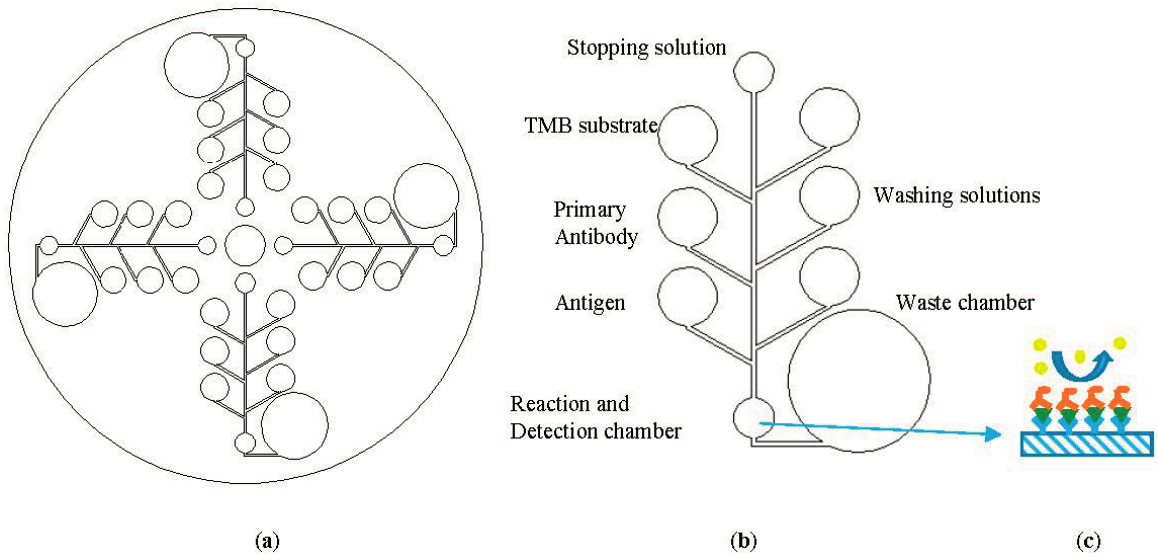
Figure 1. A general scheme of ( a ) a Lab-on-Compact Disc (LOCD) ELISA with four sets of assays; ( b ) a single assay showing reservoirs for various reagents; and ( c ) antigen coating on the detection chamber substrate with primary and secondary antibody attachment (adapted from [16]). The reagents are sequentially released into the reaction chamber and the end product colour change is detected by an optical